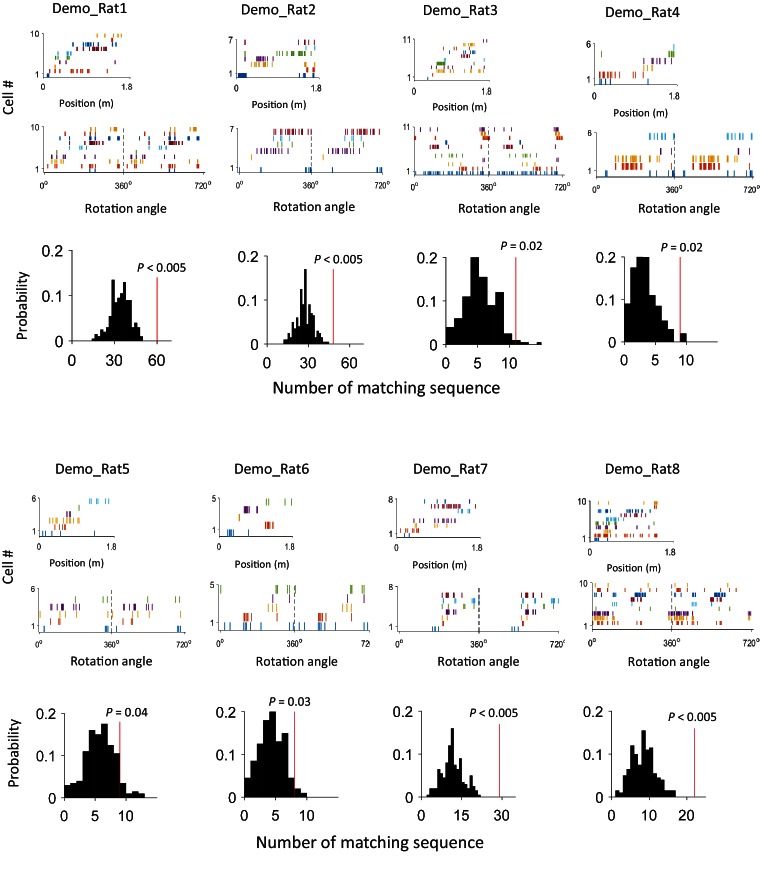
An example of matching sequence and the number of matching sequences in box sessions when a demonstrator was present (Demo: Trained-demo and Naïve-demo sessions combined) in each individual rat (Rat1 - Rat8).For each rat, we plot an example sequence similarly as in Figure 4A (top), and the actual number of matching sequences (red line) relative to the distribution (black histogram) of randomly-generated number of matches (bottom).